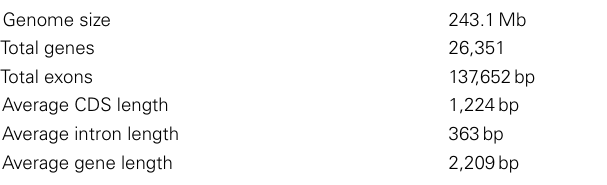
Table 3 | Statistics of predicted genes in E. salsugineum